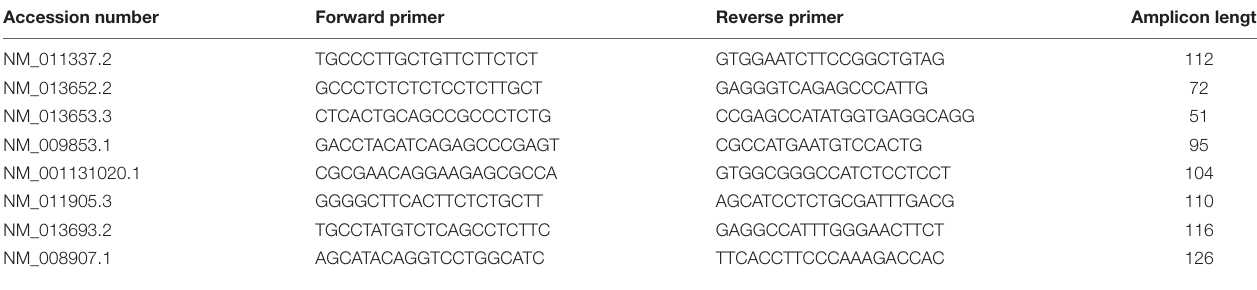
TABLE 3 | List of primers used for mRNA detection of neuroinflammatory markers by quantitative